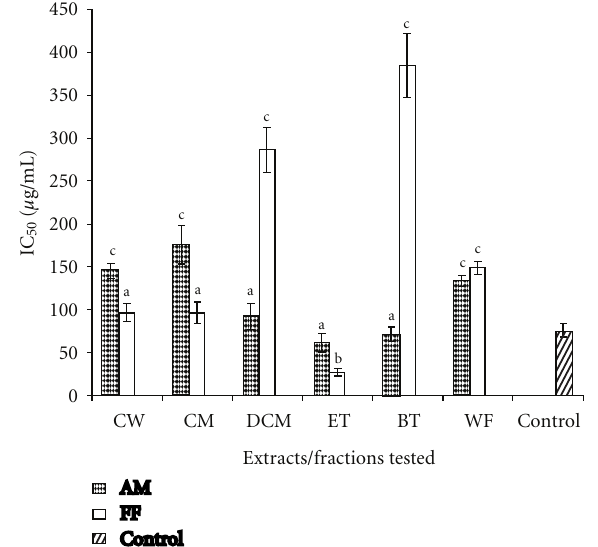
Figure 1: IC 50 values ( μ g/mL) for the active extracts/fractions of AM and FF against α -amylase activity. CW: crude water; CM: crude methanol; DCM: dichloromethane; ET: ethylacetate; BT: n -butanol; WF: water fraction. Positive control: Acarbose. a Values comparable to positive control. b Values significantly lower ( P < 0 . 05) from positive control. c Values significantly higher ( P < 0 . 05) compared to positive